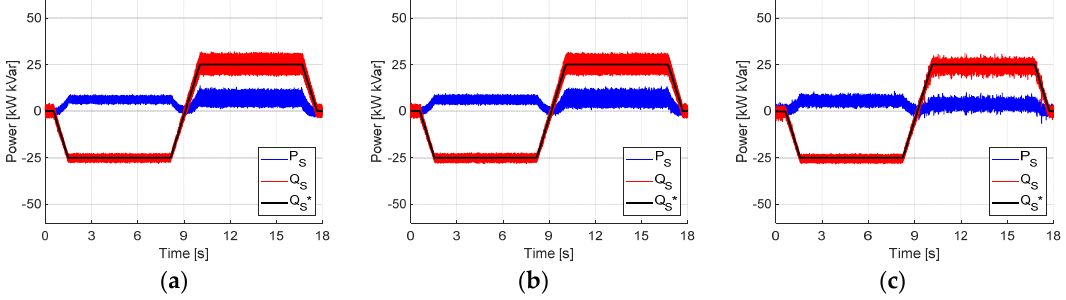
Figure 9. Active and reactive power: ( a ) CHB ( 4000 µ F ) ; ( b ) CHB ( 1200 µ F ) ; ( c ) CHB-SDC ( 1200 µ F ) .